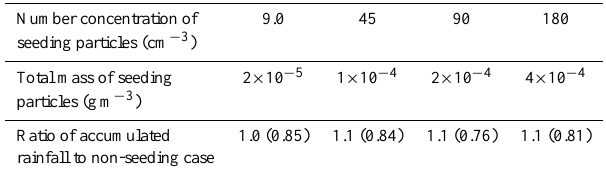
Table 5. Ratios of seeded-case to non-seeded-case accumulated sur- face rainfall averaged over the domain at 160min. Seeding of strat- iform cloud is carried out with salt micro-powder of different con- centrations. Ratios of seeded-case to non-seeded-case (180cm − 3 ) cloud droplet number concentrations at 100m above the base of the cloud center at 62min are shown in